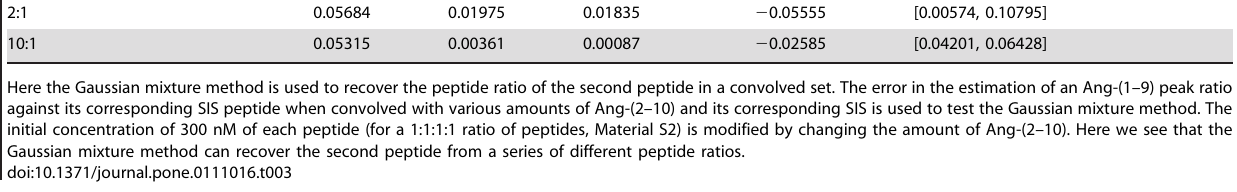
Figure S1 A short workflow of the GMM algorithm used to fit MALDI-TOF MS data.